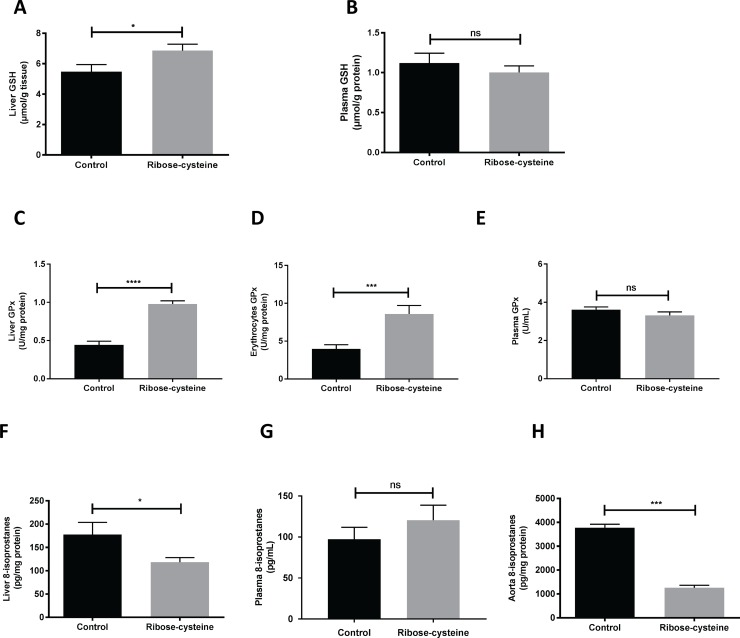
Ribose-cysteine increases liver GSH and GPx activity and decreases total 8-isoprostanes in liver and aortae of apoE-/- mice.ApoE-/- (12-week old) were treated with 4–5 mg/day ribose-cysteine in their drinking water for 8 weeks with control apoE-/- mice given normal drinking water (n = 15 per group). The GSH content of tissues and plasma was measured by LC-MS. The GPx activity in liver, erythrocytes and plasma was measured by spectrophotometric assay. Total 8-isoprostanes in liver, aortae and plasma were measured by an 8-isoprostane EIA kit. (A) Liver GSH (n = 15), (B) Plasma GSH (n = 15), (C) Liver GPx activity (n = 15), (D) Erythrocyte GPx activity (n = 15), (E) Plasma GPx activity (n = 15), (F) Total 8-isoprostane in the liver (n = 15), (G) Free 8-isoprostanes in the plasma (n = 15), (H) Total 8-isoprostane in a sample of 5 pooled arteries analysed in triplicate. *p < 0.05, *** p < 0.001, **** p < 0.0001, ns; not significant. Error bars indicate means ± SEM.